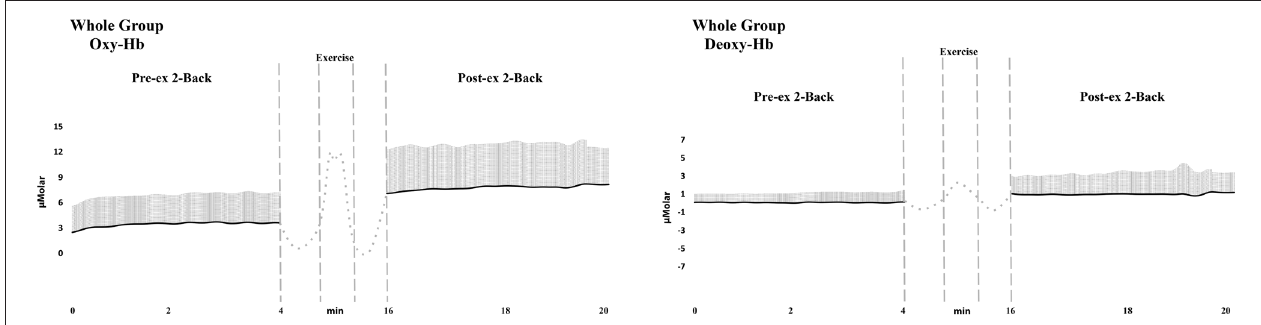
FIGURE 3 | The demonstration of oxy- and deoxy-Hb average levels in central PFC area during pre- and post-exercise 2-Back tests for the whole group. Standard deviations are also marked in line with average as vertical lines (Note that only positive deflection is displayed for the sake of simplicity). Left panel indicated oxy-Hb and right panel indicated deoxy-Hb results. Vertical scale denotes the strength of fNIRS signal in µ Molar units, which is normalized to baseline. Horizontal scale denotes the time scale in minutes. Vertical dashed lines denote pre-, during and post- exercise onsets and durations. The dotted lines represent the periods of warm-up and